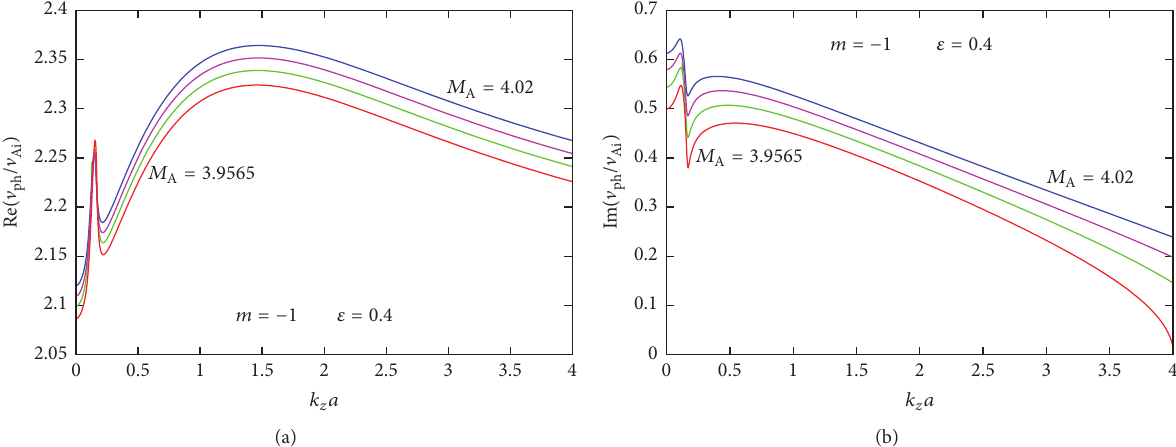
Figure 9: (a) Dispersion curves of unstable ( 𝑚 = −1 ) MHD mode propagating in a moving twisted flux tube of incompressible plasma (modeling jet #11) at the same parameters as in Figure 8 and for 𝑀 A = 3.9565 , 3.98 (green curve), 4.0 (purple curve), and 4.02. (b) The normalized growth rates for the same values of 𝑀 A